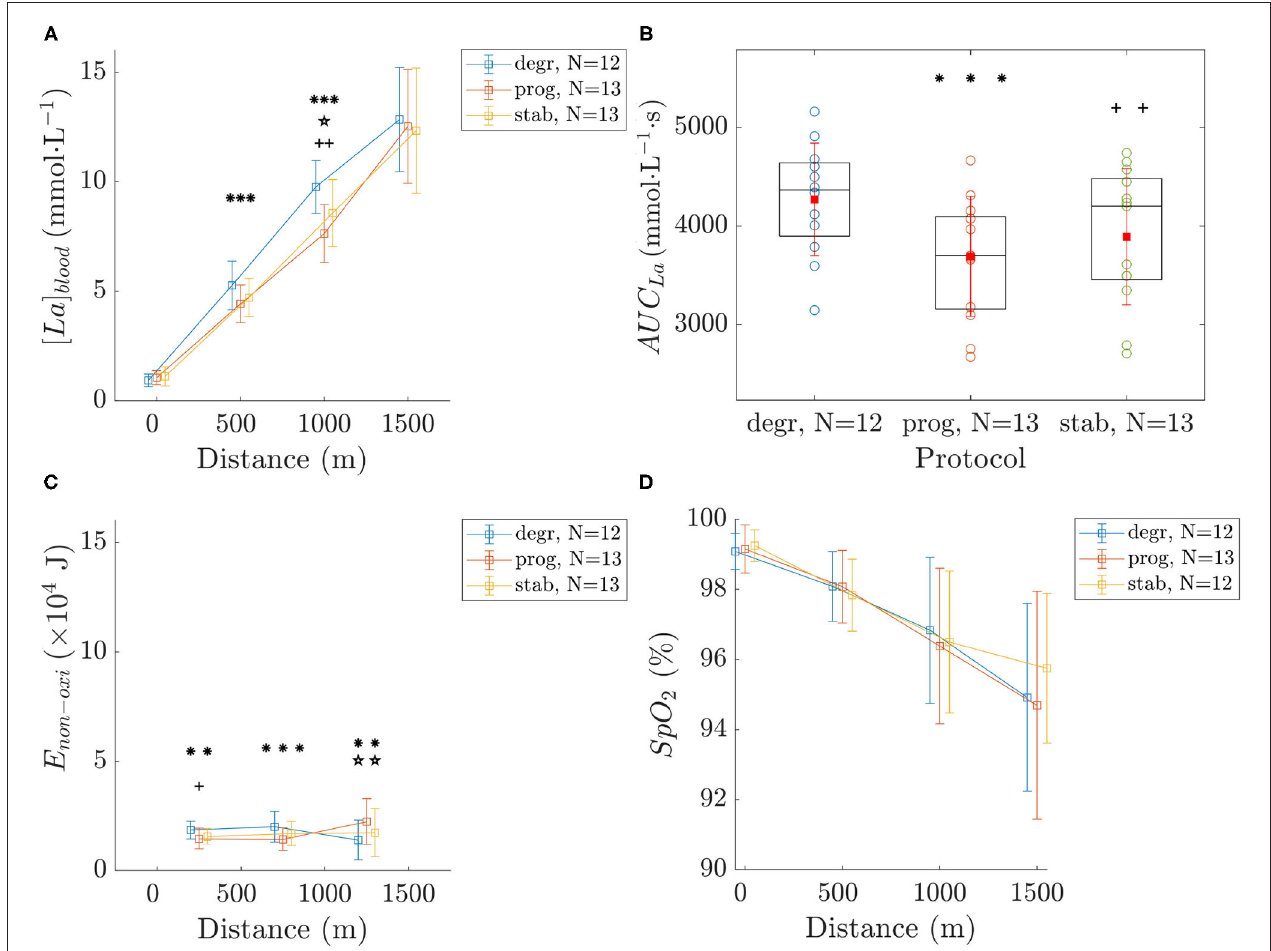
FIGURE 3 | [ La ] blood (A) , AUC La (B) , E non − oxi (C) , and SpO 2 (D) . Values are mean ± SD. The symbols ∗ , ⋆ , and + indicate a significant difference between degr - prog , prog - stab , and stab - degr , respectively. The number of symbols (one, two, or three) indicate the p -value ( < 0.05, < 0.01, and < 0.001,